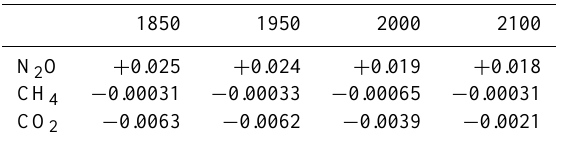
Table 2. Steady state 2-D model calculated ozone depletion poten- tial (ODP) relative to CFC-11 for N 2 O, CH 4 , and CO 2 for the years indicated, based on the values listed in Table 1.